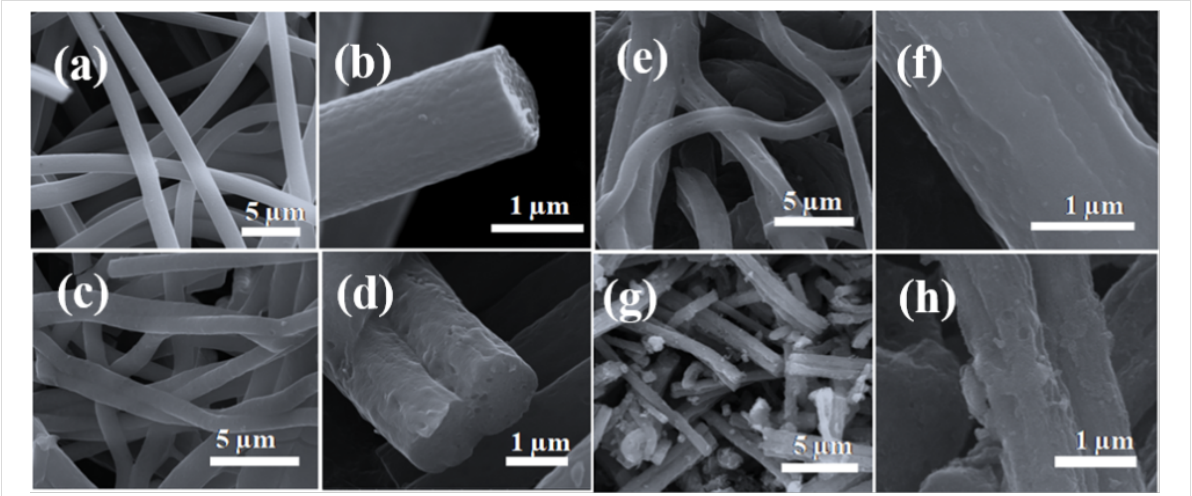
Figure 5: FE-SEM images of (a) CNF, (c) PCNF, (e) Cu/PCNF, (g) Cu/CuO/PCNF/TiO 2 composites and (b), (d), (f) and (h) magnified images of CNF, PCNF, Cu/PCNF, and Cu/CuO/PCNF/TiO 2 composites, respectively.